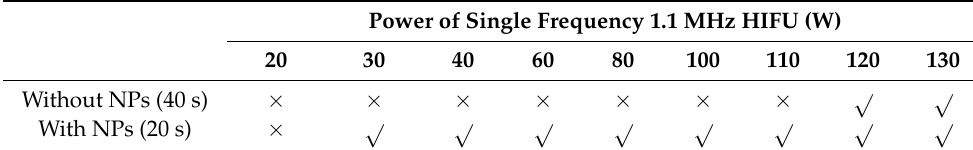
Table 3. Acoustic threshold for 1.1 MHz HIFU with and without PFP@Polymer NPs.